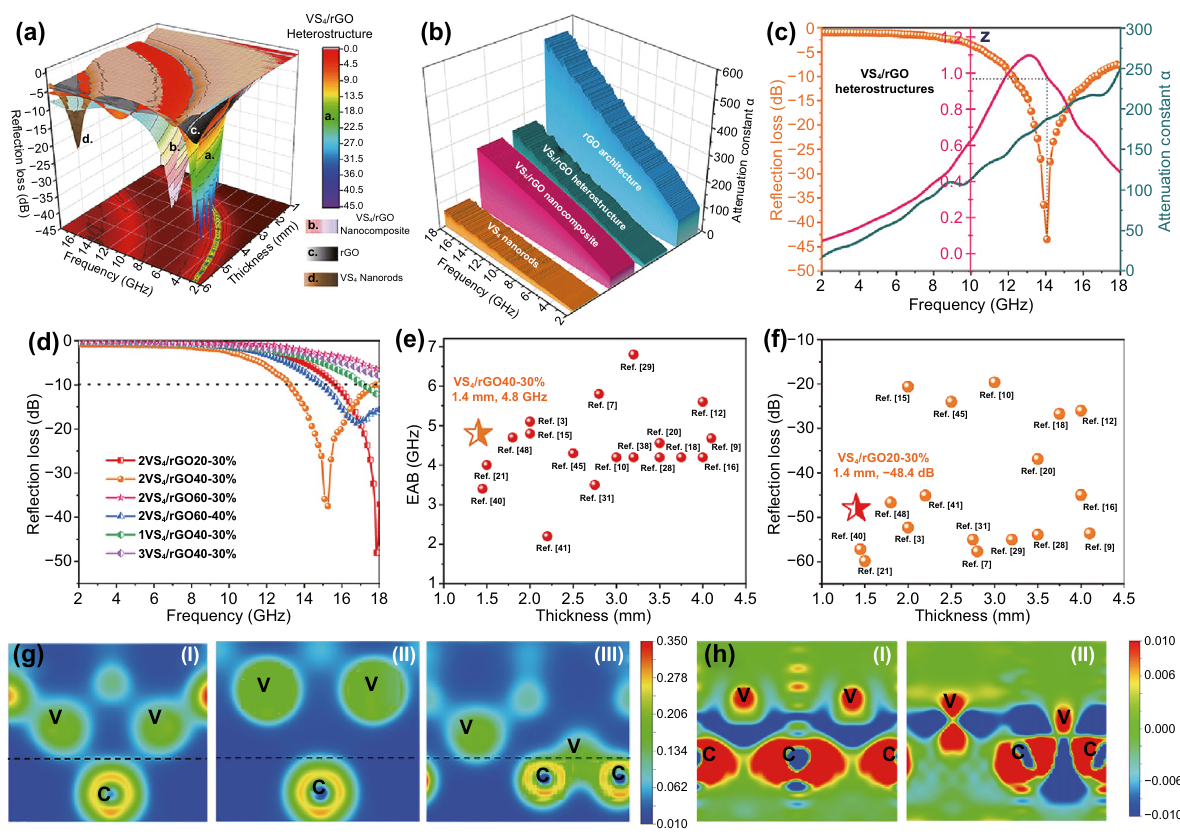
Fig. 6 a 3D RL presentations of rGO, VS 4 nanorods, VS 4 /rGO nanocomposite, and VS 4 /rGO heterostructure (2VS 4 /rGO40-30%). b Attenuation constant α of rGO, VS 4 nanorods, VS 4 /rGO nanocomposite, and VS 4 /rGO heterostructures (2VS 4 /rGO40-30%). c Frequency dependence of RL, attenuation constant α and |Z in /Z 0 | at 1.5 mm for 2VS 4 /rGO40-30%. d RL of different VS 4 /rGO heterostructures at 1.4 mm. Comparison of some typical graphene-based absorbents for e EAB and f RL max at different thickness. g Charge density of the interfaces (I) VS 4 (-2 0 4)/rGO (1 0 0) interface, (II) VS 4 (0 2 0)/rGO (1 0 0) interface, (III) VS 4 (1 1 0)/rGO (1 0 0) interface. h Charge density difference of (I) VS 4 (-2 0 4)/rGO (1 0 0) and (II) VS 4 (1 1 0)/rGO (1 0 0)